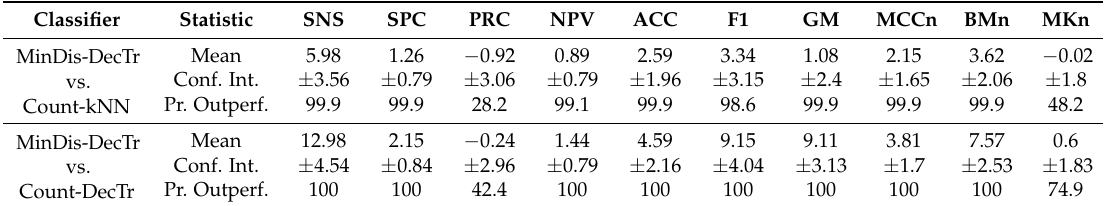
Table 9. Performance improvement (%) over the simpler counting